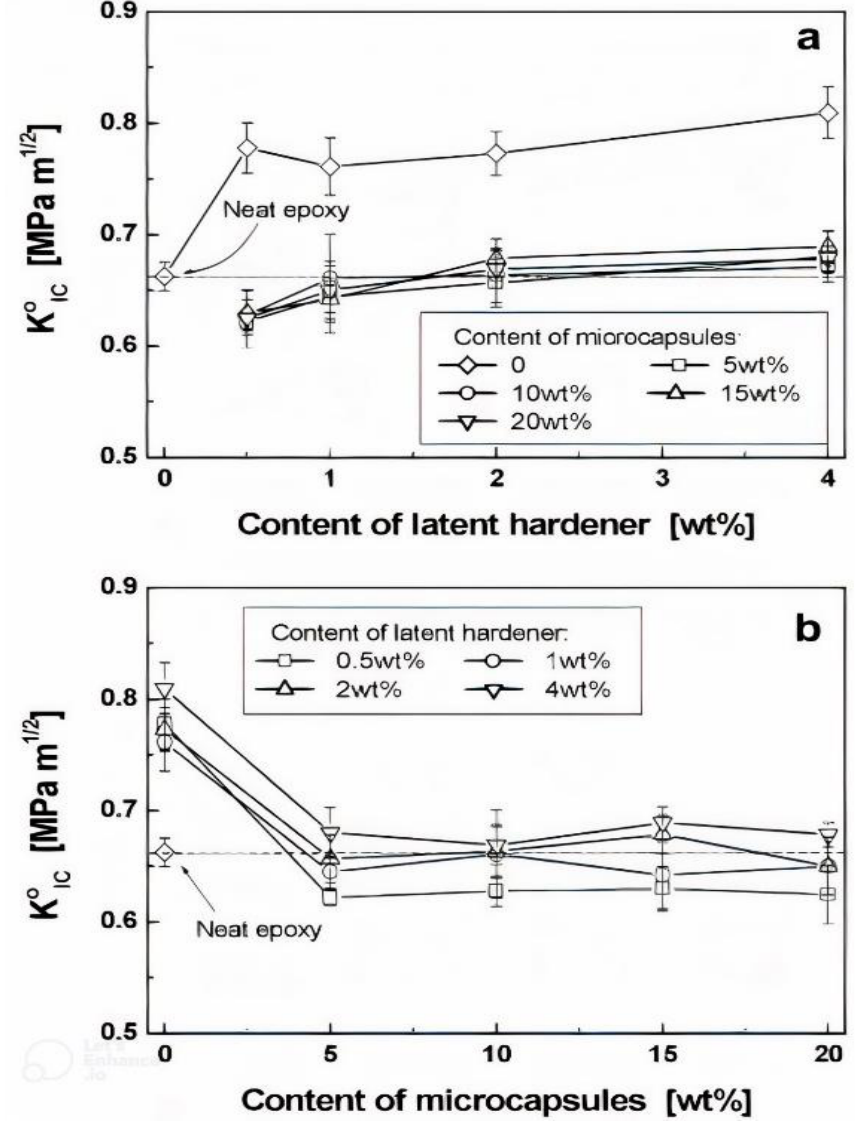
Figure 20. Variation in Fracture toughness, as the latent hardener content ( a ) and ( b ) microcapsules content increases [202].